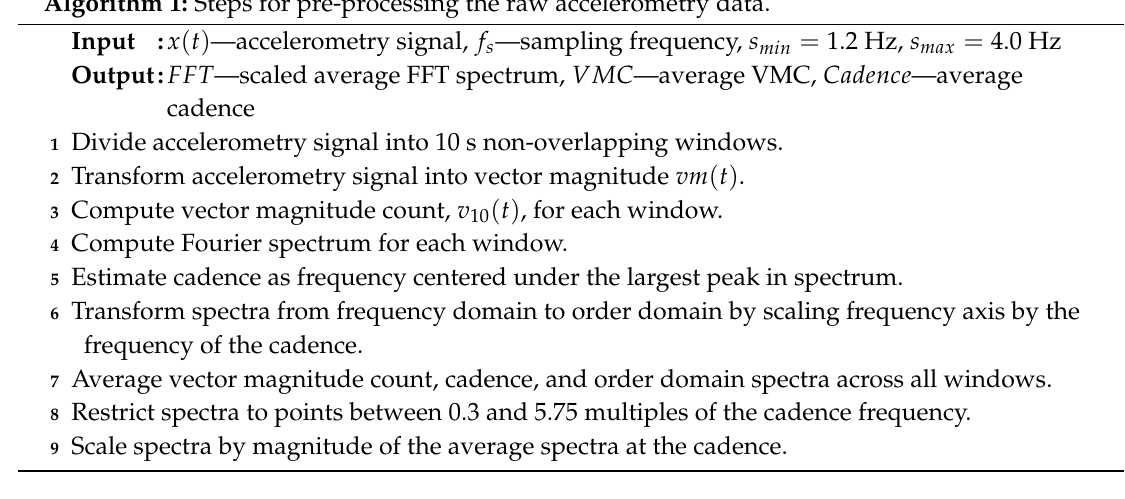
Algorithm 1: Steps for pre-processing the raw accelerometry data.